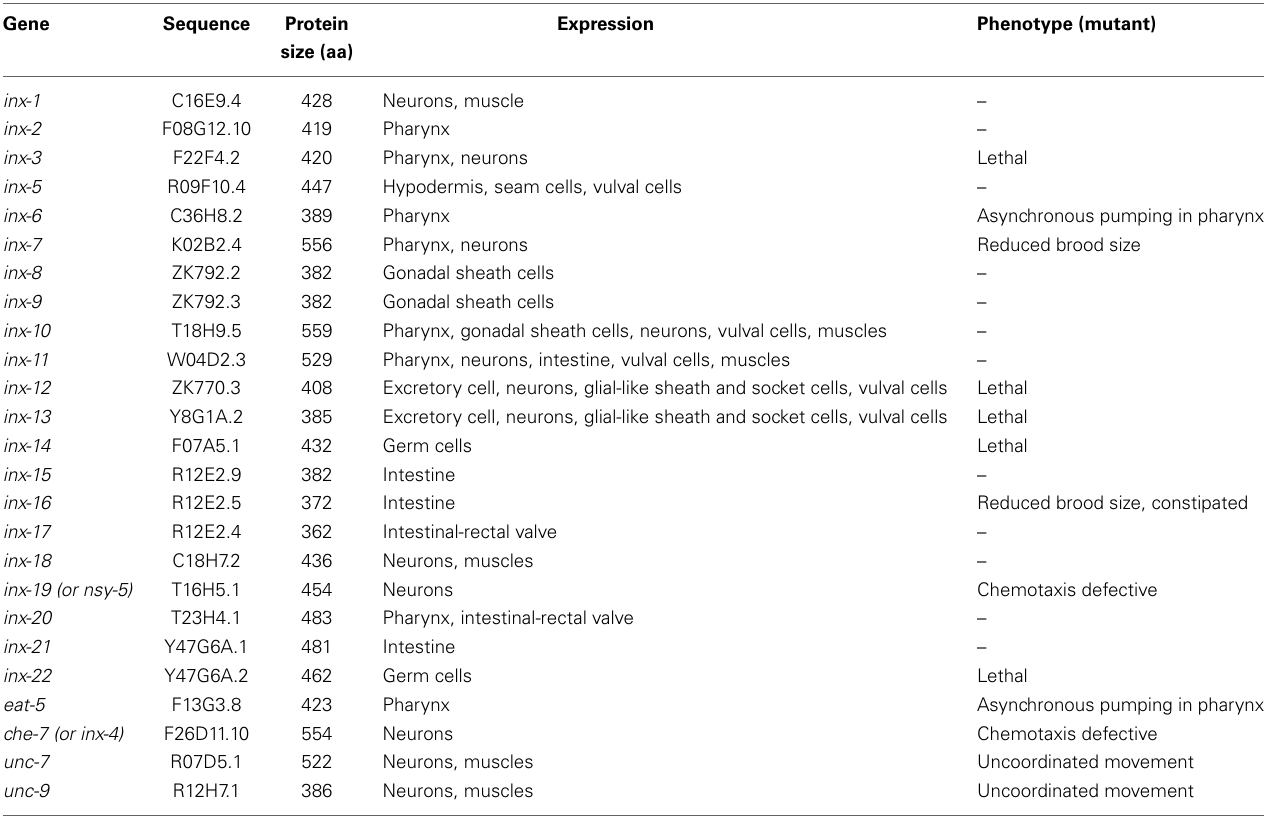
Table made using information from Wormbase release 220 (www.wormbase.org) and papers cited within the text. All C. elegans innexins have orthologs in the sequenced Caenorhabditis species C. briggsae and C. remanei (except inx-8 and inx-9 which share a single ortholog in C. briggsae ),